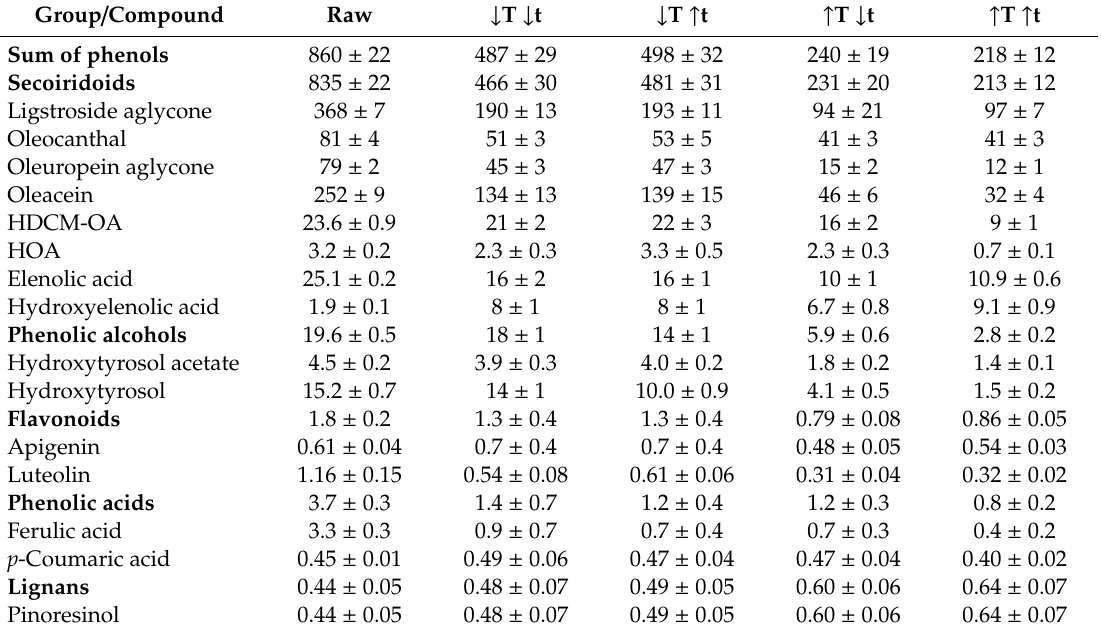
Table 2. Polyphenolic concentration of raw and processed extra-virgin olive oil (EVOO) expressed in mg / kg of EVOO.